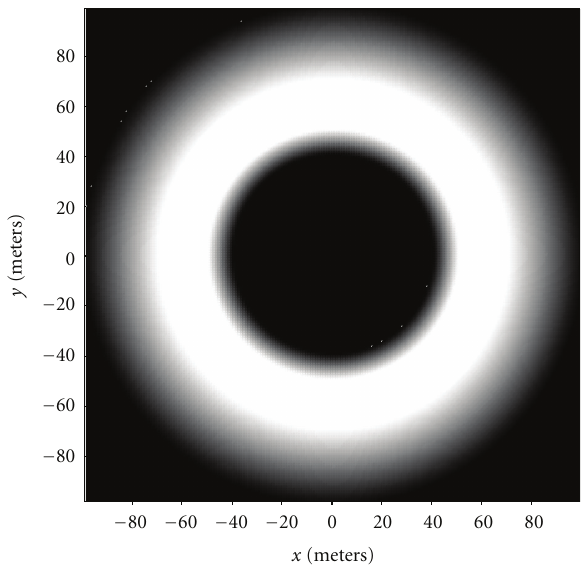
Figure 14: A sample sensor observation coverage where the quality of coverage is represented by shaded value, white being high quality and black being low quality. This type of coverage is applicable when a sensor makes good observations at some specified distance